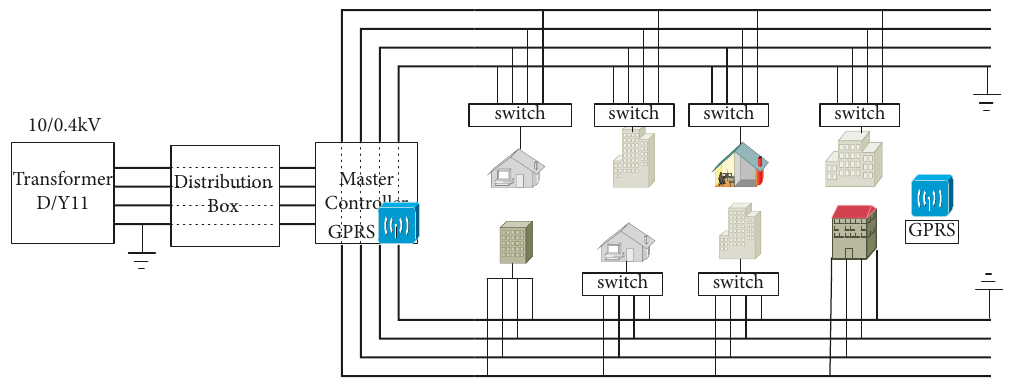
Figure 4: Station area commutation switch